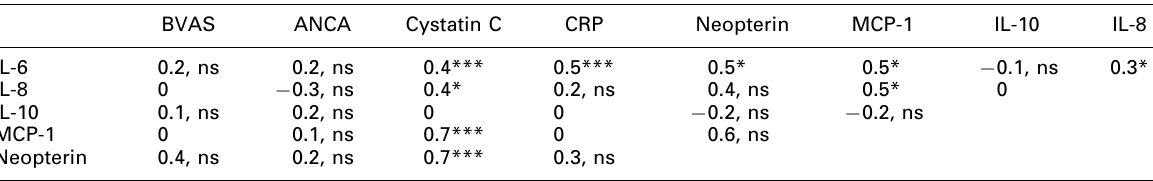
Table 3. Correlation